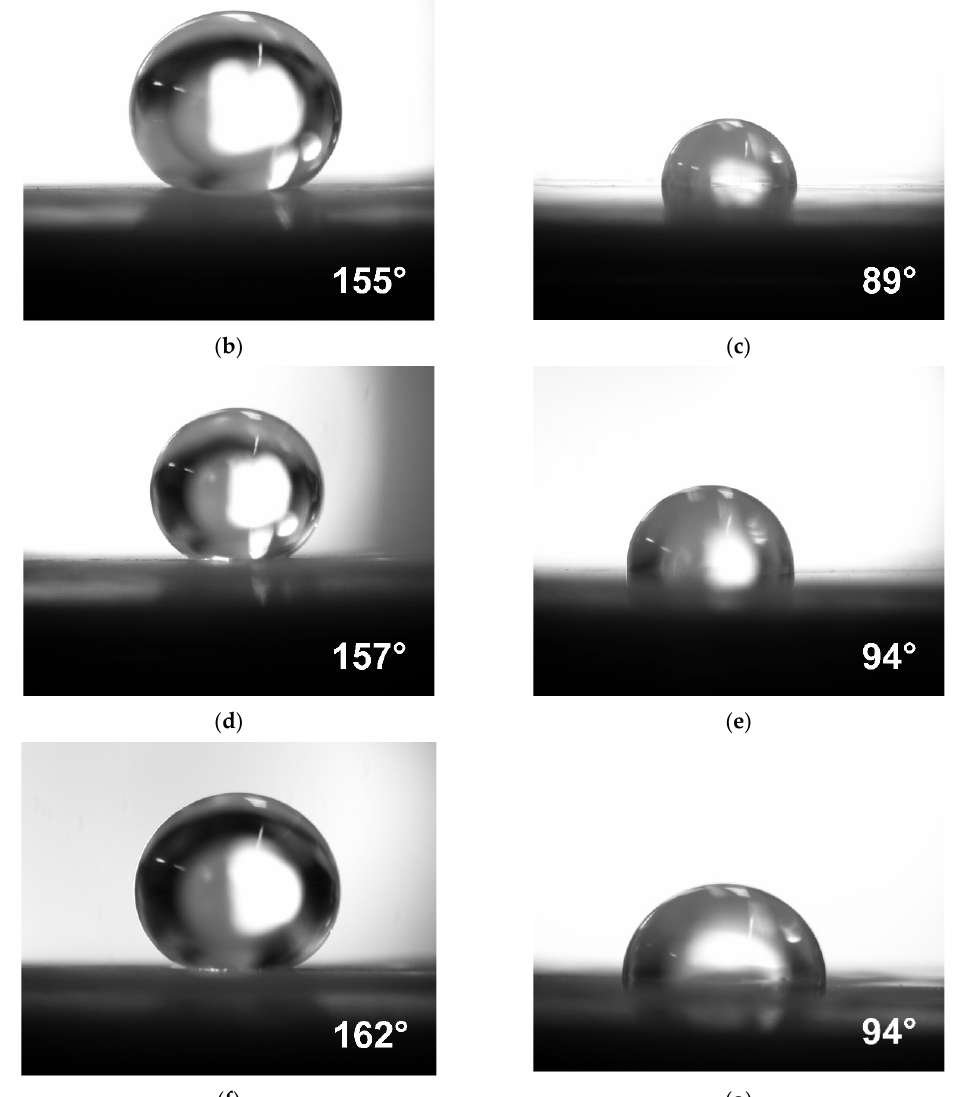
Figure 5. Measurements of the water contact angle of the membrane surface: ( a ) PTMSP membrane; ( b ) PTMSP/HCPS 90/10 wt% from the surface principally consisting of HCPS; ( c ) PTMSP/HCPS 90/10 wt% from the surface principally consisting of PTMSP; ( d ) PTMSP/HCPS 70/30 wt% from the surface principally consisting of HCPS; ( e ) PTMSP/HCPS 70/30 wt% from the surface principally consisting of PTMSP; ( f ) PTMSP/HCPS 50/50 wt% from the surface principally consisting of HCPS; ( g ) PTMSP/HCPS 50/50 wt% from the surface principally consisting of PTMSP.